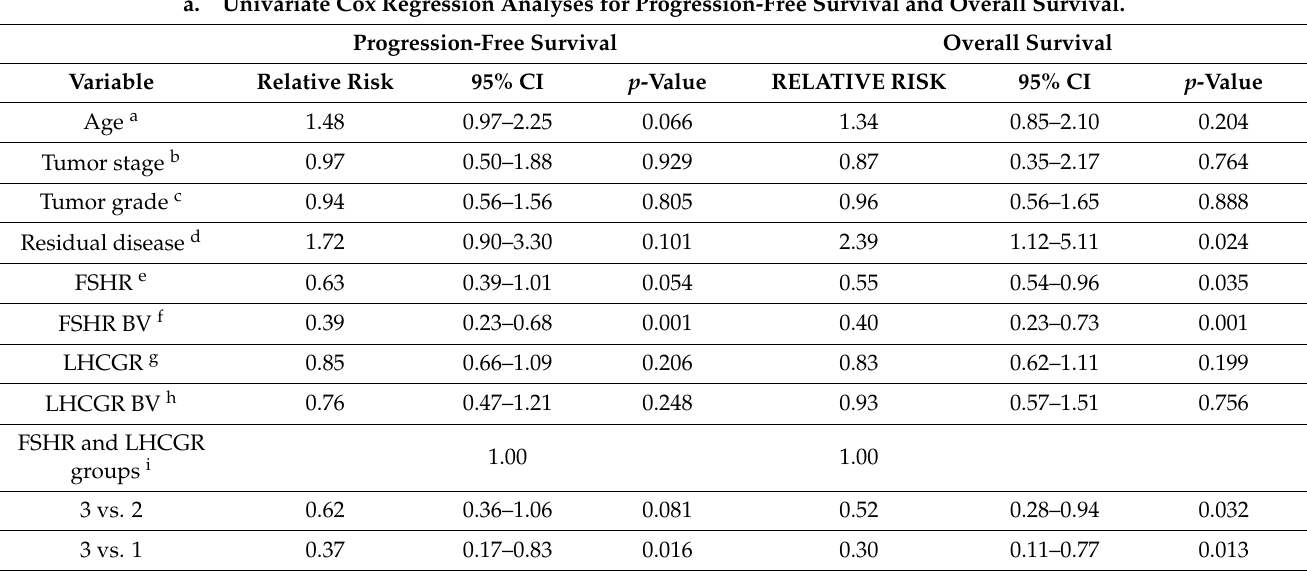
Figure 7. Kaplan–Meier survival analysis showing the relationship between LHCGR protein expression with progression- free survival and overall survival in HGSOC. ( a ) LHCGR immunoreactive score (IR) in cancer cells with PFS; LHCGR IR ≥ 3 (relapse; 63/74 patients), LR IR ≤ 2 (relapse; 21/35 patients) ( b ) LHCGR IR score in cancer cells with OS, LHCGR IR ≥ 3 (ovarian cancer death; 15/38 patients), LR IR ≤ 2 (ovarian cancer death; 57/81 patients). ( c ) LHCGR IR score in blood vessels (BVs) with PFS, LHCGR high BV (relapse; 66/39 patients), LHCGR low BV (relapse; 57/69 patients). ( d ) LHCGR IR score in BVs with OS, LHCGR high BV (ovarian cancer death; 24/42 patients), LHCGR low BV (ovarian cancer death; 47/75 patients). Log rank test. Table 1. Cox Regression analyses of the HGSOC patient cohort for FSHR and LHCGR immunostaining. a. Univariate Cox Regression Analyses for Progression-Free Survival and Overall